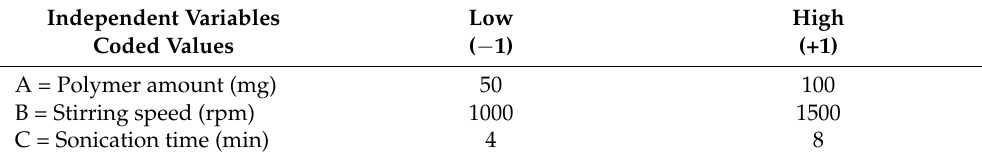
Table 8. Independent variables for Quality by Design